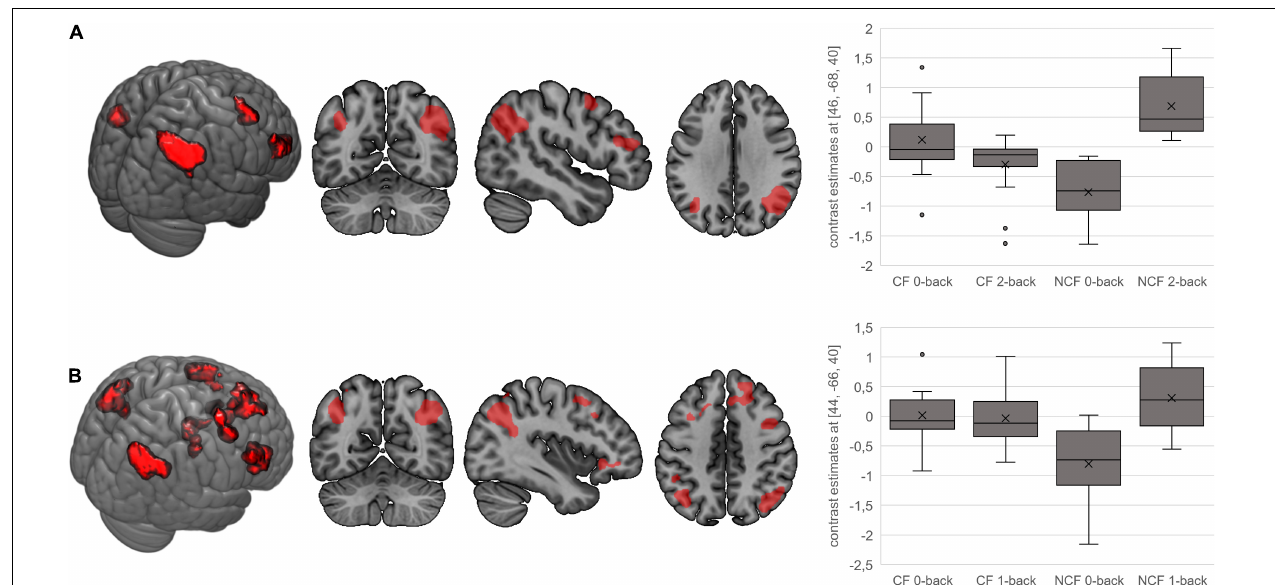
FIGURE 5 | Interactions for fatigue > no fatigue in n-back task. Highlighted areas show brain regions that show more activation in the chronic fatigue (CF) versus no chronic fatigue (NCF) group in the contrasts 0-back > 2-back (A) and 0-back > 1-back (B) . Box–whisker plots show brain activation of the major cluster’s maximum voxel in arbitrary units. Horizontal lines denote (from bottom to top) minimum, third quartile, median, first quartile, and maximum. Crosses indicate arithmetic means; points denote statistical